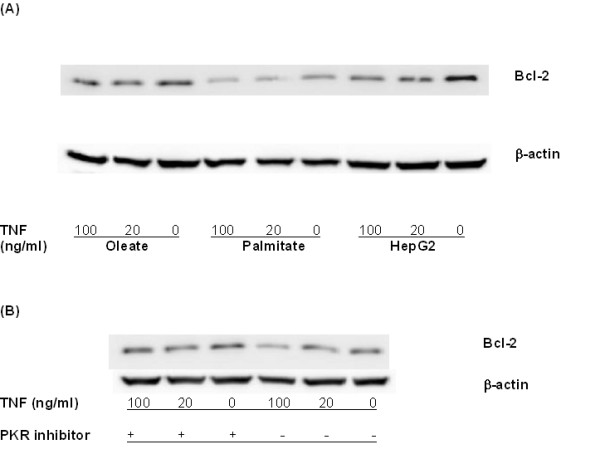
Effect of palmitate and TNF-α on Bcl-2 expression measured by western blotting. (A) TNF-α supplementation at 20–100 ng/ml downregulated Bcl-2 in the control, palmitate, and oleate cultures. Similarly, palmitate downregulated Bcl-2 protein expression level as compared to the control and oleate cultures. (B) Effect of PKR inhibition on Bcl-2 level in the palmitate cultures. PKR inhibitor (6 μM) increased the expression of Bcl-2 in palmitate cultured cells.